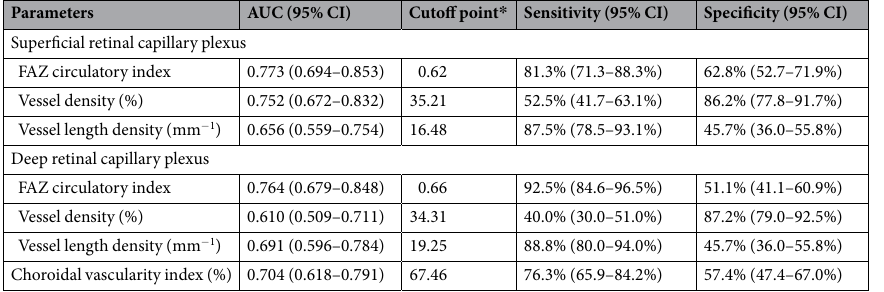
Table 4. ROC curve analysis of the vascular parameters between early and advanced DR stages. Early DR include no DR, mild NPDR, and moderate NPDR, and advanced DR include severe NPDR and PDR group. * Cutoff point based on the Youden Index. AUC, area under the curve; CI, confidence interval; DR, diabetic retinopathy; FAZ, foveal avascular zone; NPDR, non-proliferative diabetic retinopathy; PDR, proliferative diabetic retinopathy; ROC curve, receiver operating characteristic